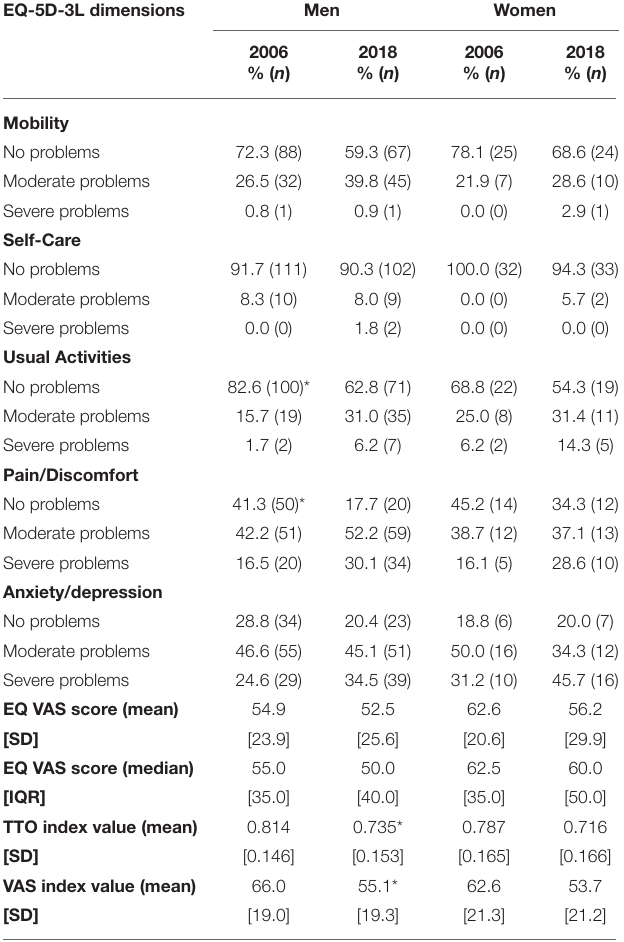
TABLE 3 | Problems in EQ-5D-3L dimensions (%, n ), mean and median EQ VAS score, mean TTO index value, mean VAS index value, by sex, homeless people in 2006 and 2018,